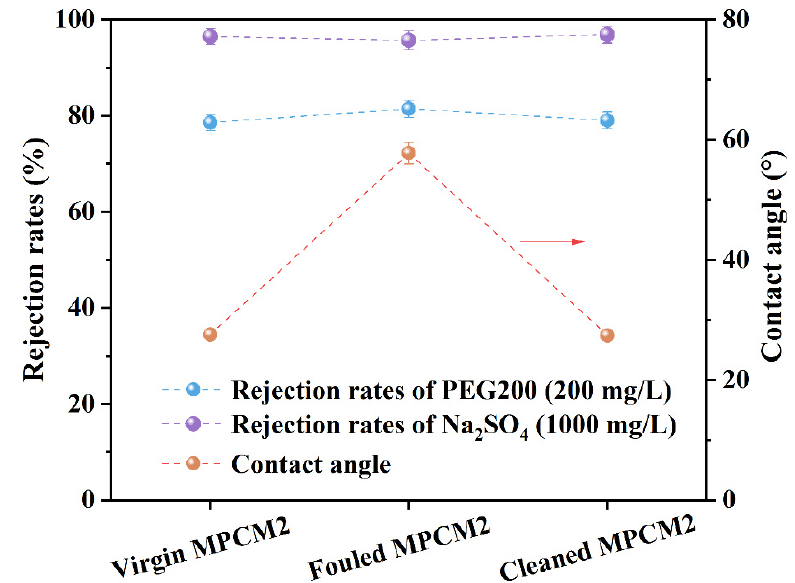
Figure 7. Influence of EDTA–HCl cleaning on MPCM2 properties.